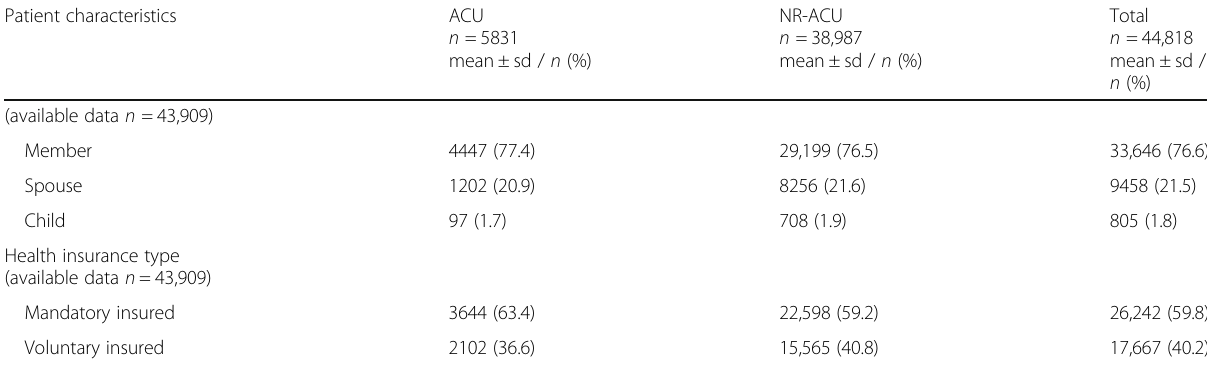
Table 1 Baseline characteristics for the acupuncture in routine care (ARC) patients by the treatment groups randomized acupuncture (ACU) and non-randomized acupuncture (NR-ACU) (Continued) Patient